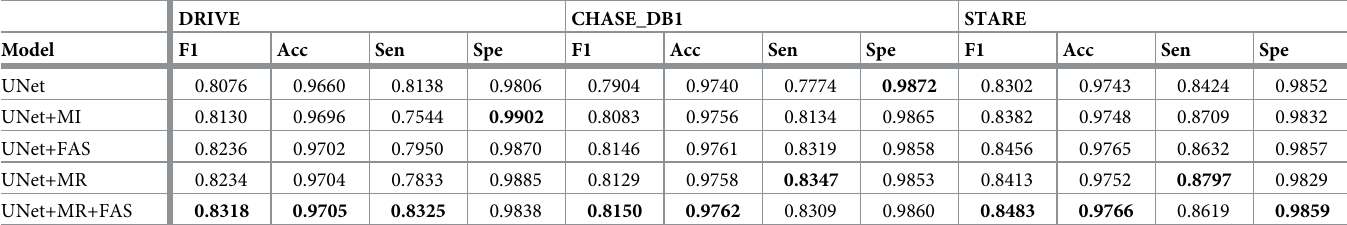
Table 1. Ablation experiment